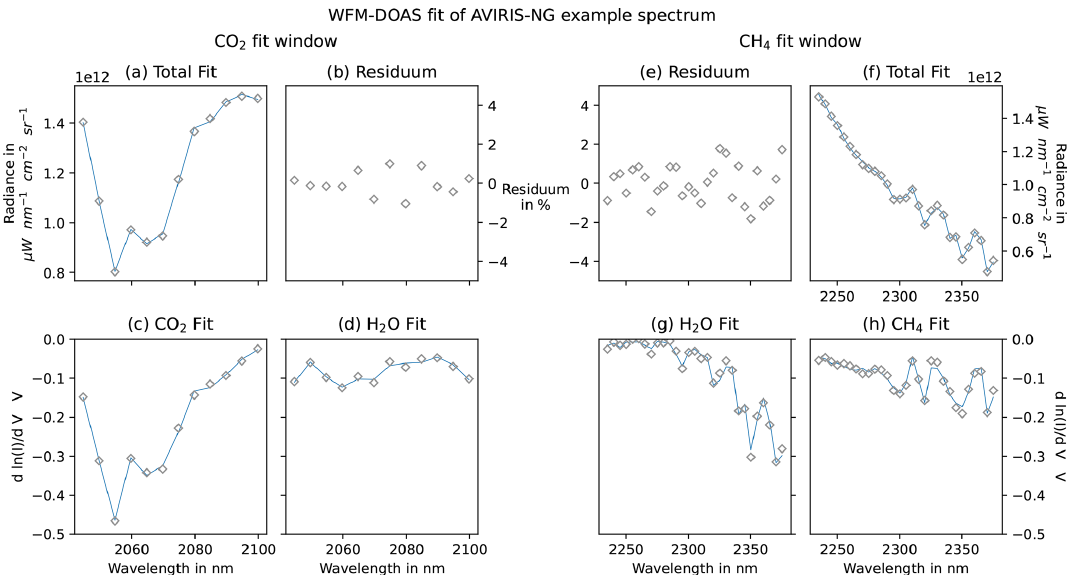
Figure 1. Example fit result of the WFM-DOAS retrieval for AVIRIS-NG data. The left block (a–d) shows the CO 2 fitting window (2040– 2100nm), and the right block (e–h) shows the CH 4 fitting window (2235–2380nm). In panels (a) and (h) , the fit result is shown as a solid blue line, while the actual measured intensities are shown as gray diamonds. The difference between the gray diamonds and the line is the residuum which is shown in panels (b) and (e) . In the second row, the scaled weighting functions for CO 2 and H 2 O in the CO 2 window (c, d) and for CH 4 and H 2 O in the CH 4 window (g, h) are shown as solid lines. The gray diamonds show the fit result plus the residuum to assess if the residual structures are larger than the actual fitted structures. In the CH 4 fit window, the residuum shows some structure which might indicate some residual correlation between water vapor and methane signature in the real measurements which can not be fully resolved by the